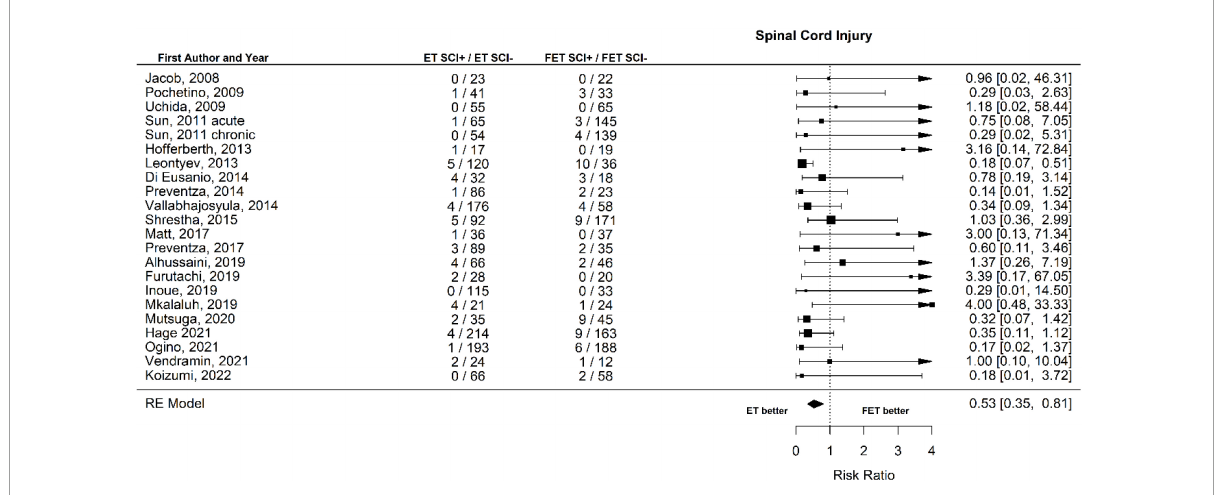
FIGURE4 Relative risk of spinal cord injury (SCI) and hemiplegia/paraplegia in patients undergoing aortic interventions with conventional elephant trunk (ET) vs. frozen elephant trunk (FET). Forest plot. ET vs. FET: p =